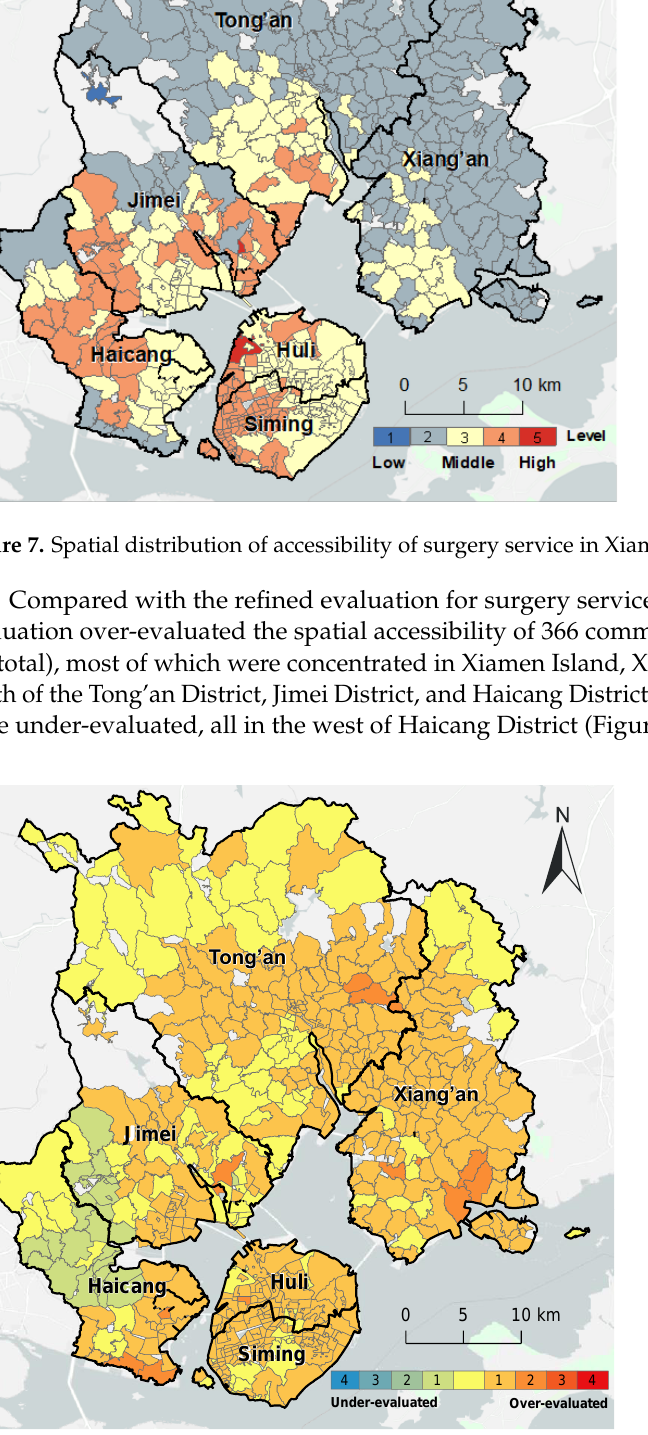
Figure 9. Spatial distribution of accessibility of gynecology and obstetrics services in Xiamen City.